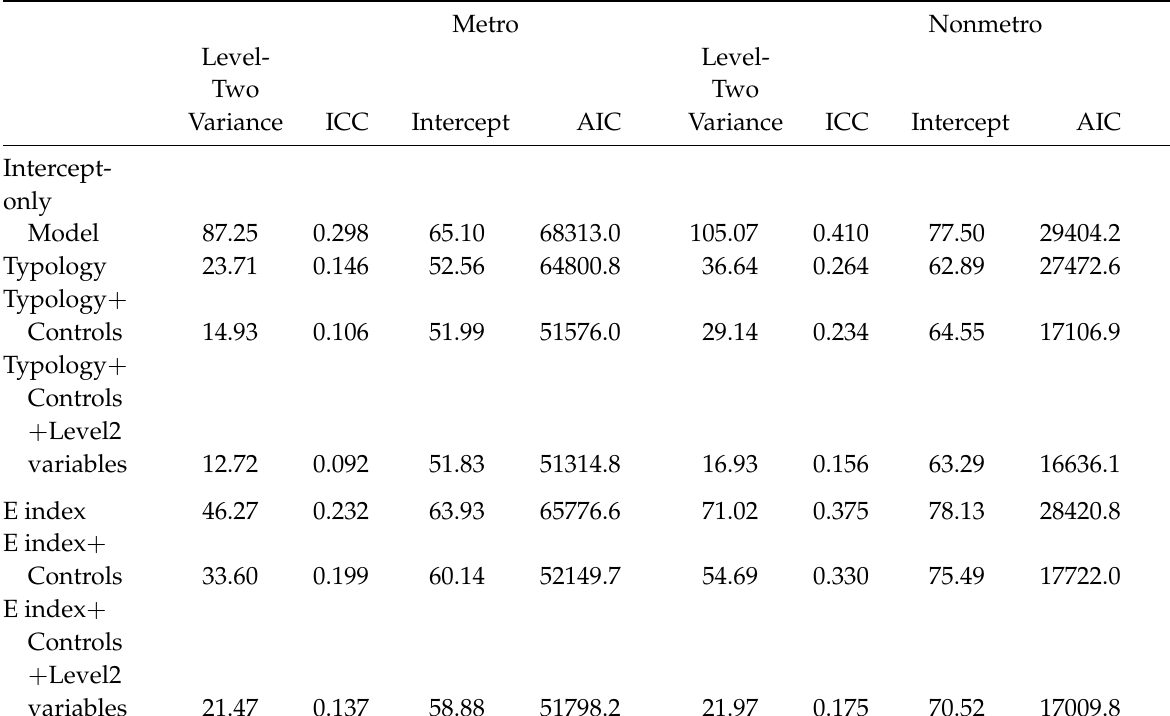
Table 7: Fit Statistics from Models of Place Black-White Residential Segregation,